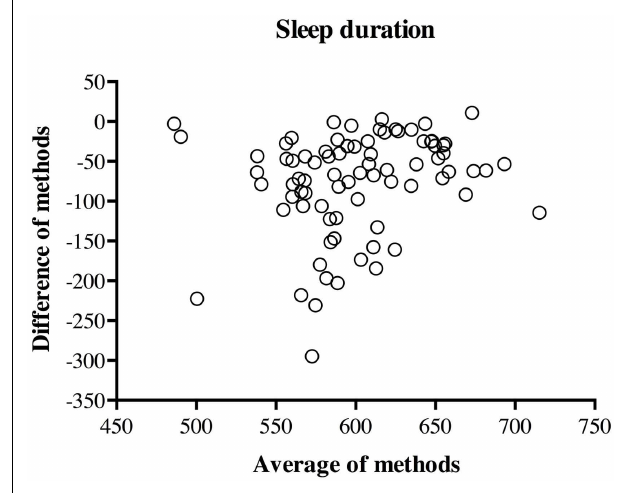
FIGURE 1 | Plot of between-methods difference by across-method average for sleep duration .